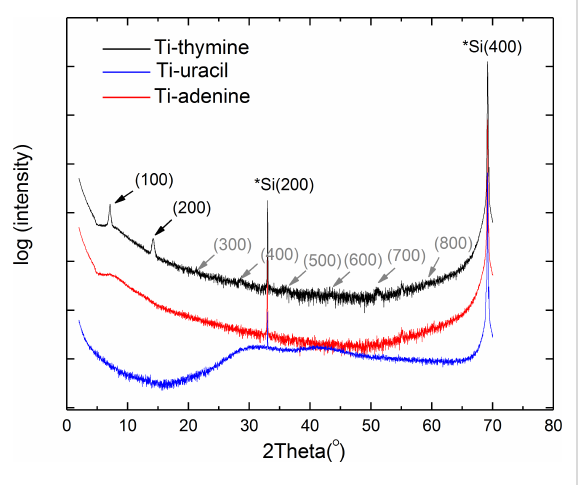
Figure 10: θ –2 θ X-ray diffractogram for the Ti-thymine film deposited at 250 °C (black line), Ti-uracil deposited at 225 °C (blue line), and Ti-adenine 250 °C (red line). The reflections for the Ti-thymine film and their multiples are indicated by arrows.